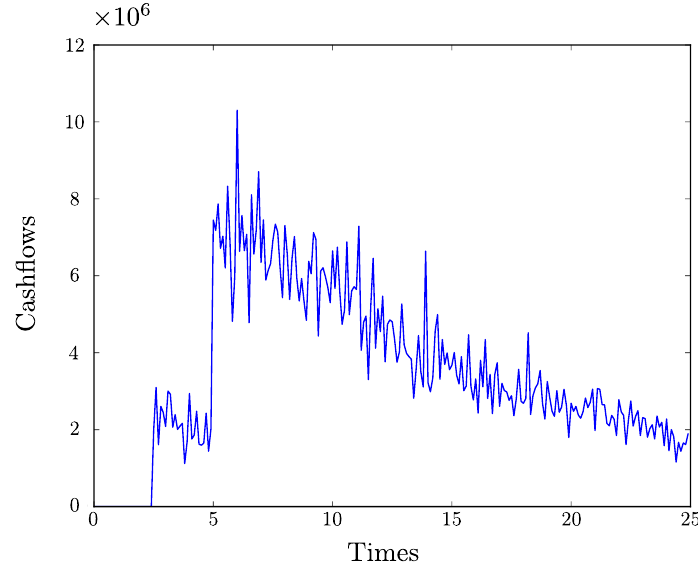
Figure 6. Cash flows associated to the original portfolio in Example